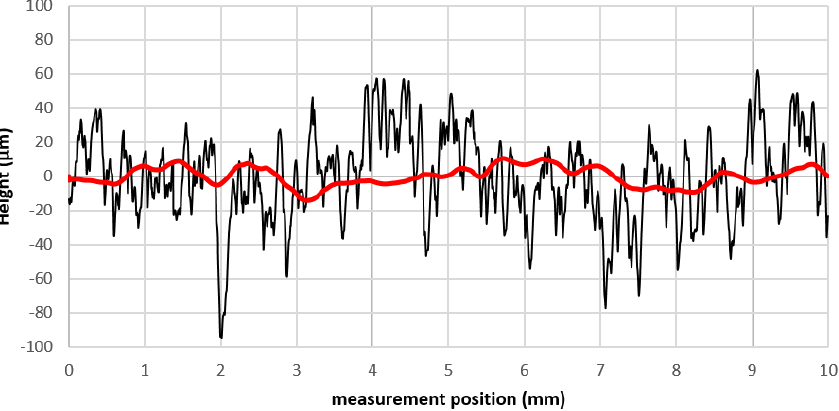
Figure 8. Surface roughness profile of an untreated SLS sample compared to the result of applying a 30-layer PVDF coating by ultrasonic spray coating.